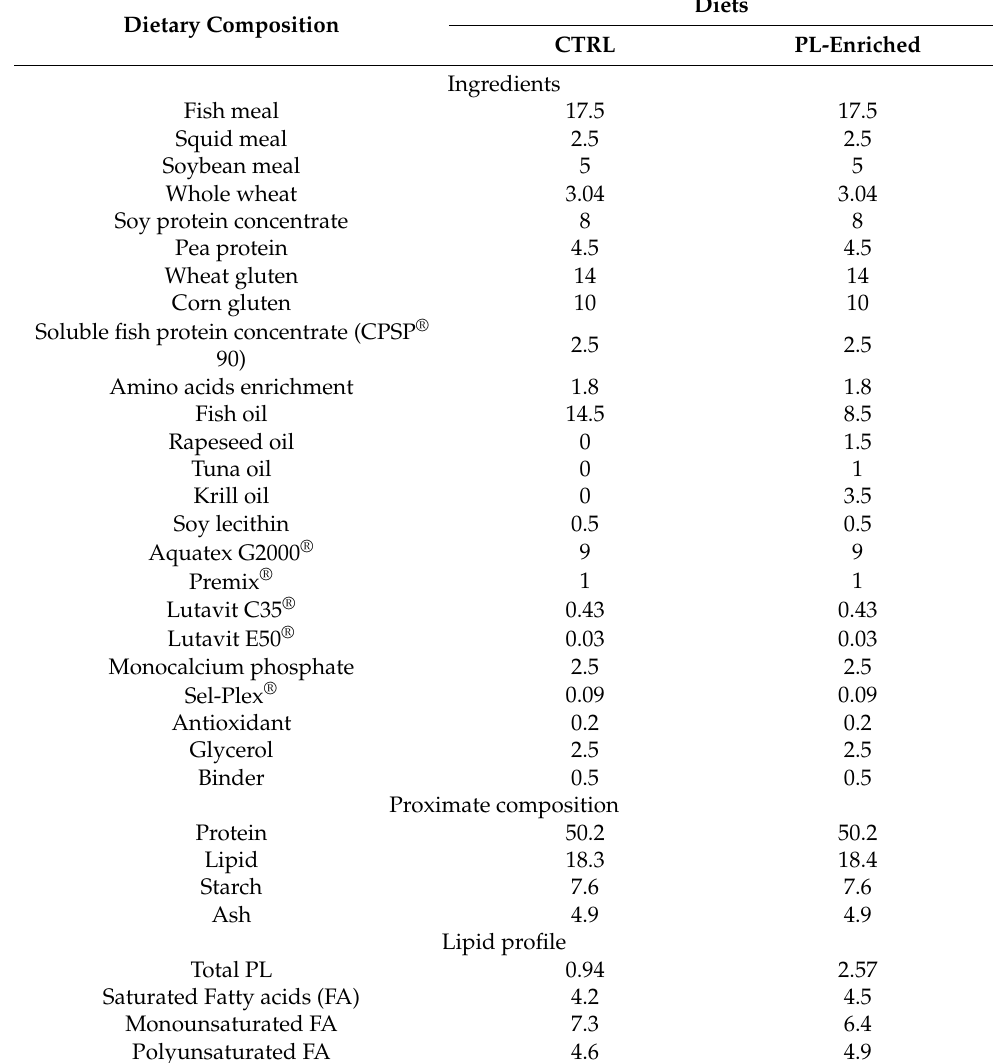
Table 1. Formulation and proximate composition (% dw) of experimental control (CTRL) and phospholipid(PL)-enriched